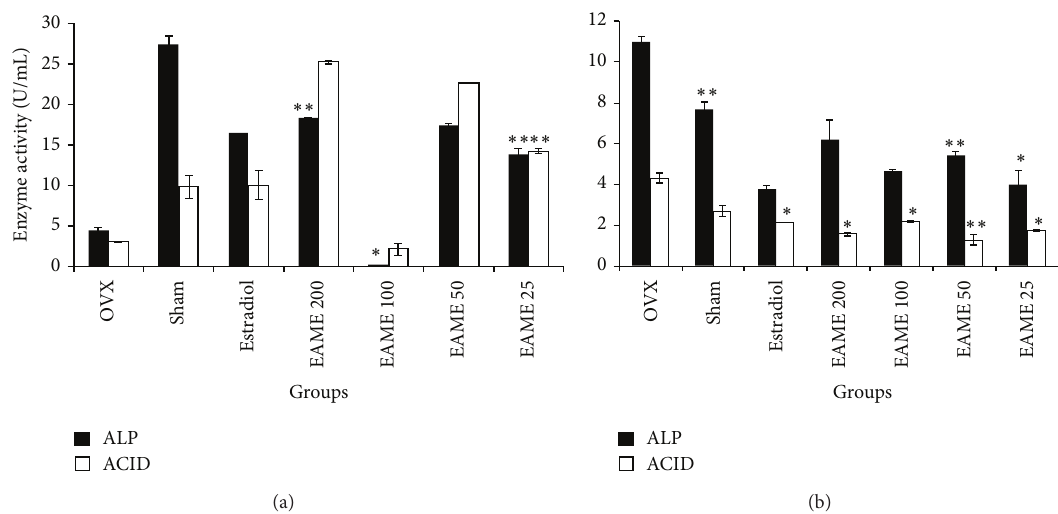
Figure 1: Effect of EAME on bone turnover markers alkaline phosphatase (ALP) and acid phosphatase (ACP). Serum was collected from control mice, ovariectomised mice treated with EAME and estradiol after the first and fourth week of oral administration of the extracts, and the levels of ALP, ACP were measured. (a) Effect of EAME on serum levels of ALP and ACP in OVX mice after the first week. (b) Effect of EAME on serum levels of ALP and ACP in OVX mice after the fourth week. All values are expressed as mean ± SEM, ∗ 𝑃 < 0.01 versus OVX, ∗∗ 𝑃 < 0.001 versus